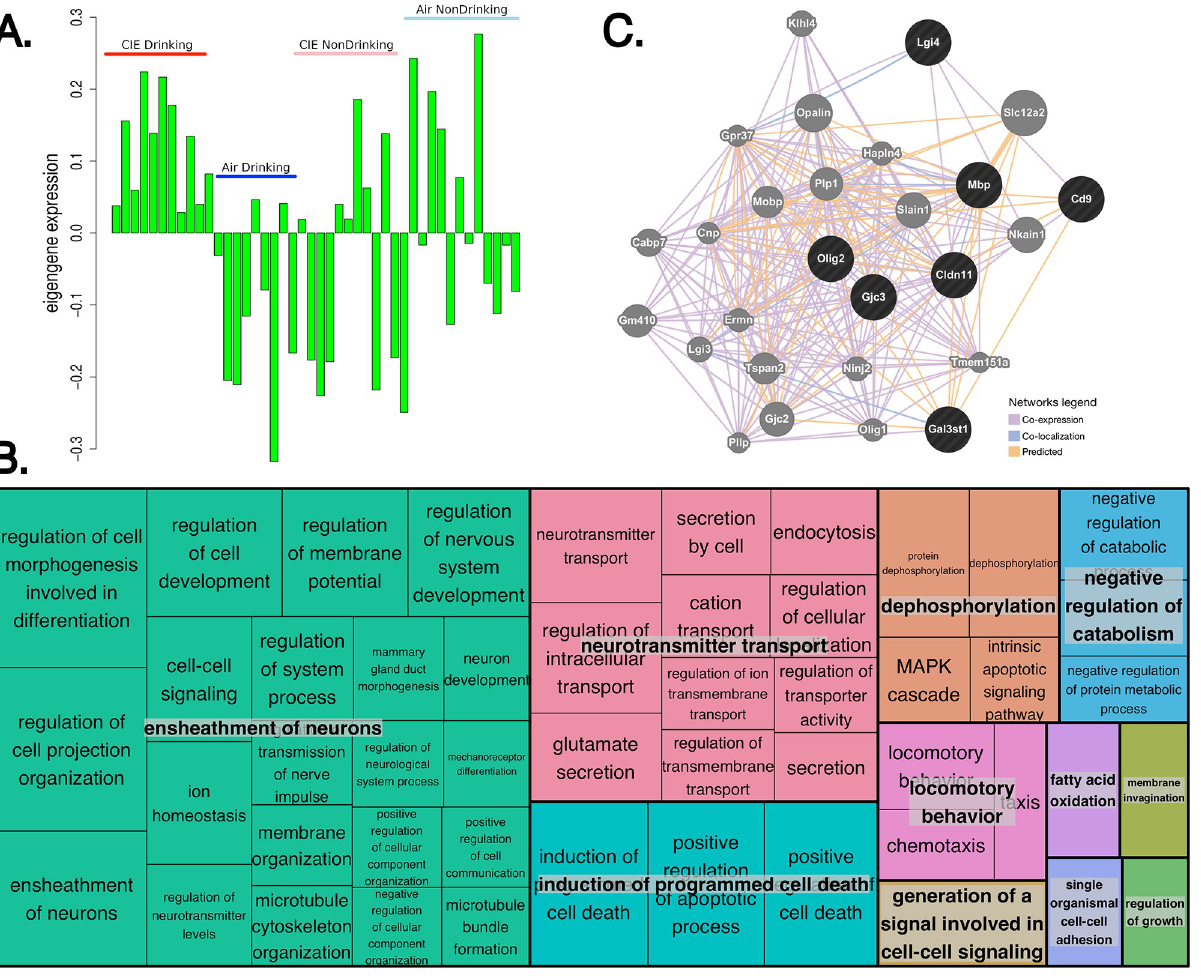
Fig 6. Eigengene expression for each sample in PFC green module, Gene Ontology enrichment, connectivity of myelin genes. A) Eigengene (1 st principal component) value from each PFC sample. Red = CIE Drinking, Blue = Air Drinking, Pink = CIE NonDrinking, Light blue = Air NonDrinking. B) Gene Ontology biological processes significantly enriched in the PFC green module, grouped by biological theme using REVIGO. C) GeneMANIA network generated from PFC green module genes involved in myelination.